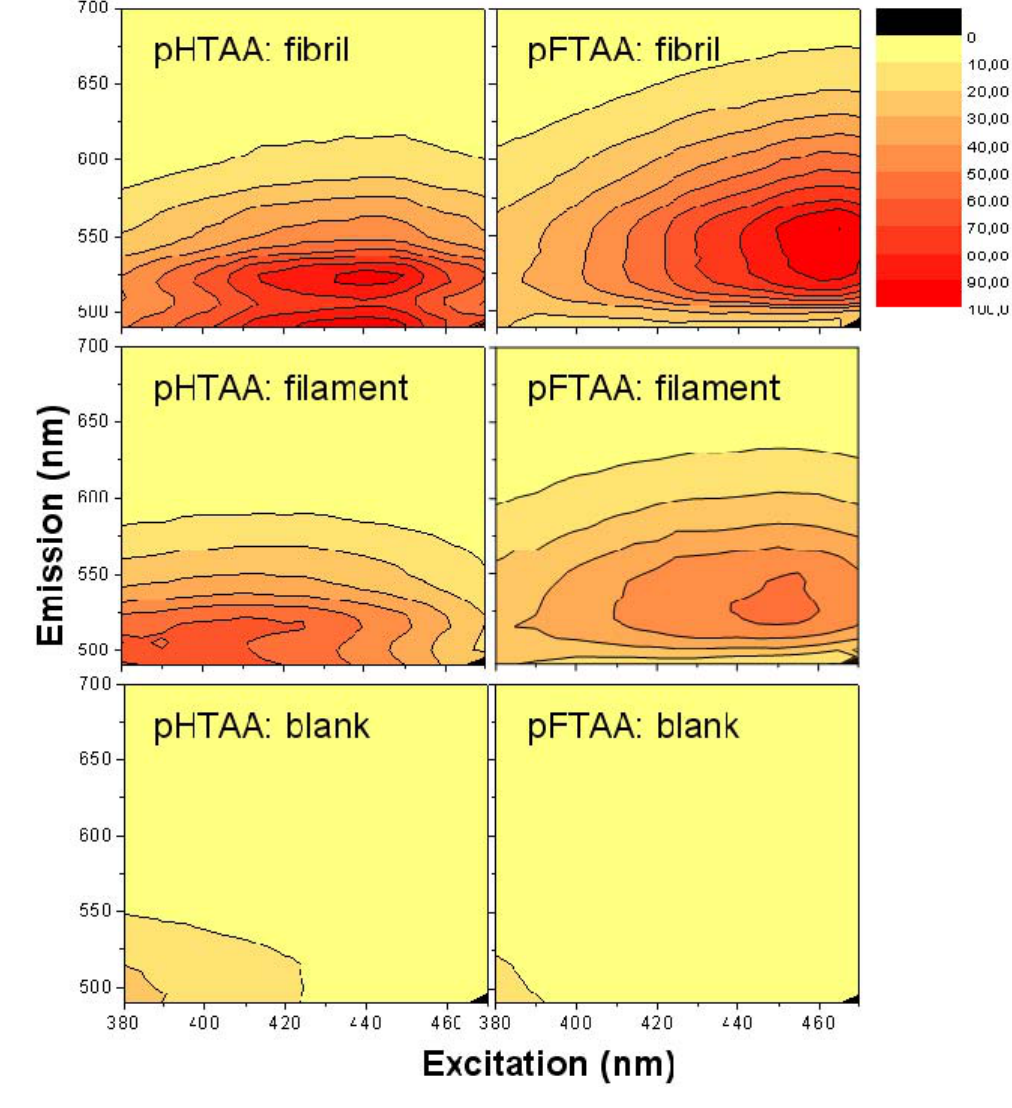
Figure 3. Excitation and emission spectra obtained at pH 2.0 directly after formation of fibrils and filaments staining with p -HTAA and p -FTAA. All 3D plots have the same intensity scale as shown in the bar to the